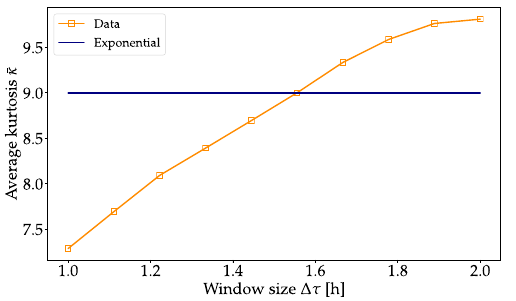
Figure 8. The average kurtosis ¯ κ of the data set is plotted as a function of the time window �τ in hours (yellow). The intersection between the horizontal line at ¯ κ = 9 (the kurtosis of an exponential distribution) and the ¯ κ vs (cid:31) t curve gives the optimal value for (cid:31) t ; we find T ≈ 1.55 hours.